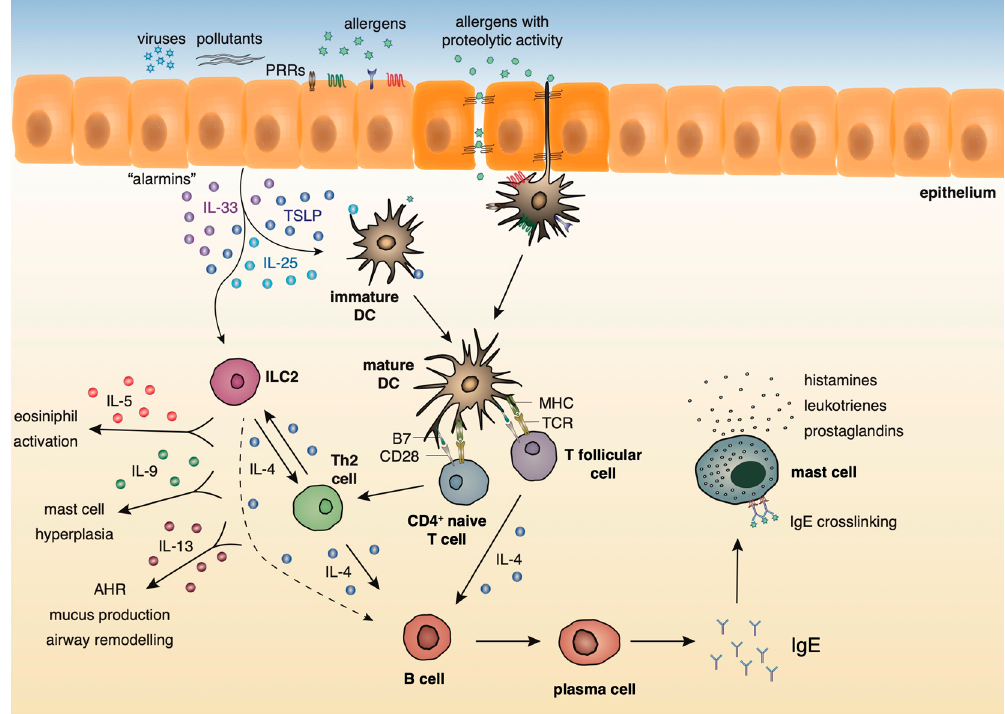
Figure 1. Innate and adaptive type 2 immunity during allergic airway inflammation.